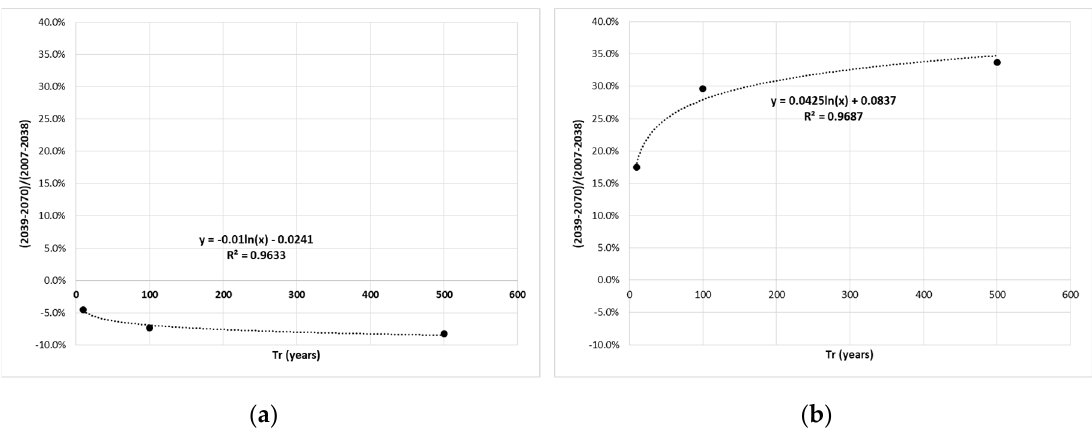
Figure 13. Second Stage (2039–2070)/1st Stage (2007–2038) economic damage ratio trend line in terms of return periods. ( a ) ANA—BCC-CSM1-1-m; ( b ) ANA—MRI-CGCM3.